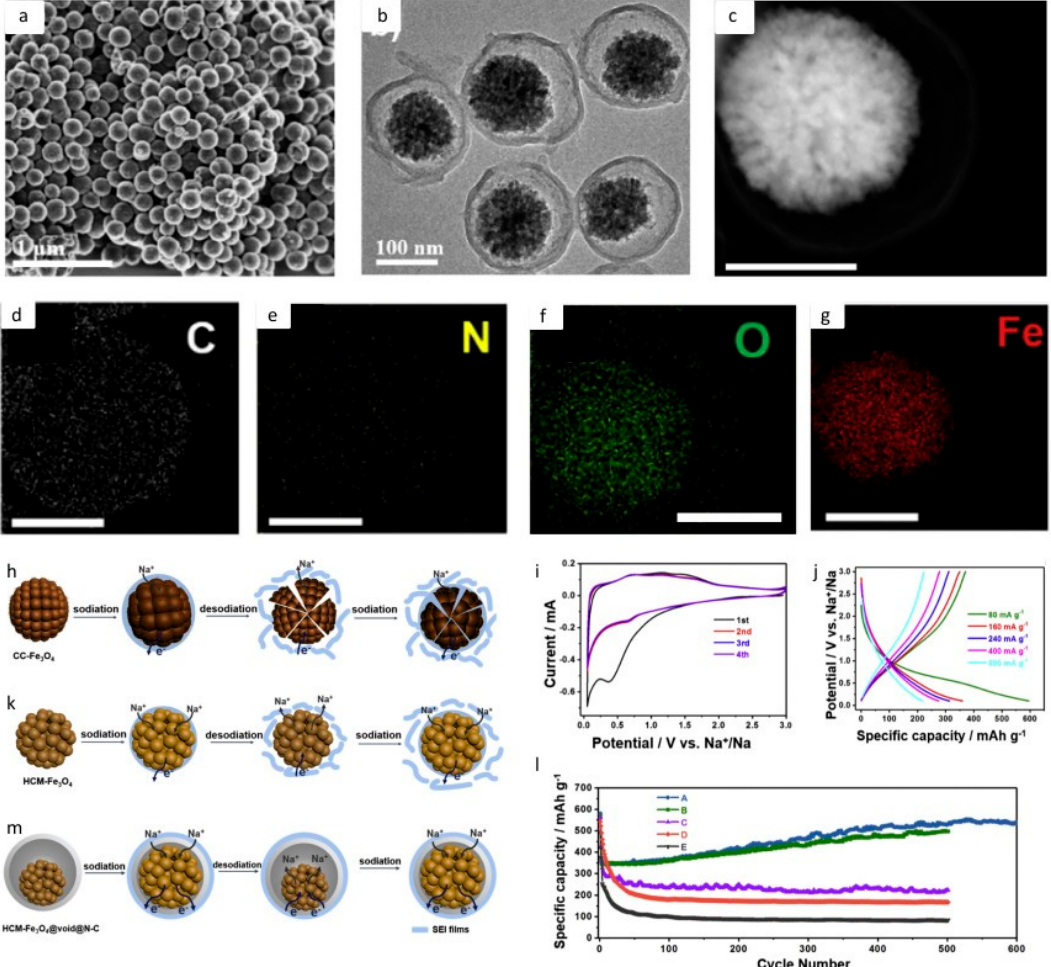
Figure 6. Structural characterization and electrochemical performance analysis of metal oxide yolk-